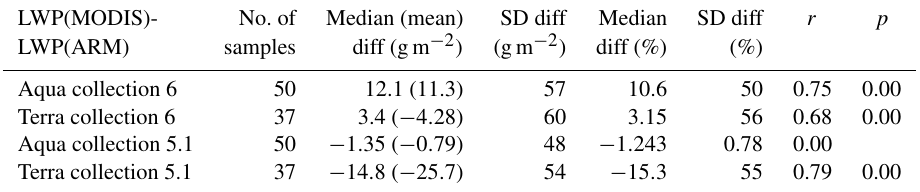
Table 6. Median and mean differences, standard deviations of the differences, correlation coefficients and p values between nighttime MODIS and ARM liquid water path (LWP). Only scenes approved in both the collection 5.1 and collection 6 screening are included in the table. LWP(MODIS)- No. of Median (mean) SD diff Median SD diff LWP(ARM)